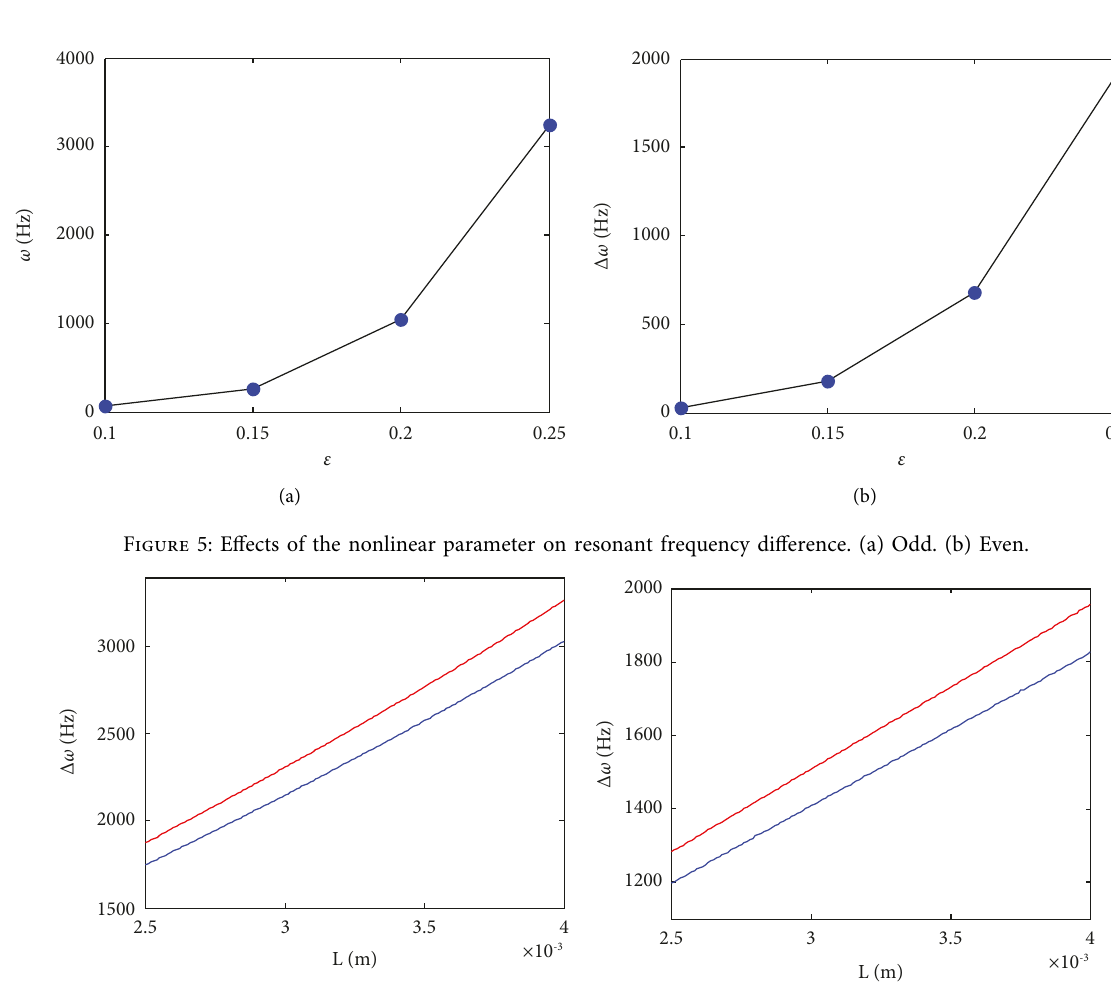
Figure 4: Effects of the nonlinear parameter on resonant frequencies. (a) Odd. (b) Even.